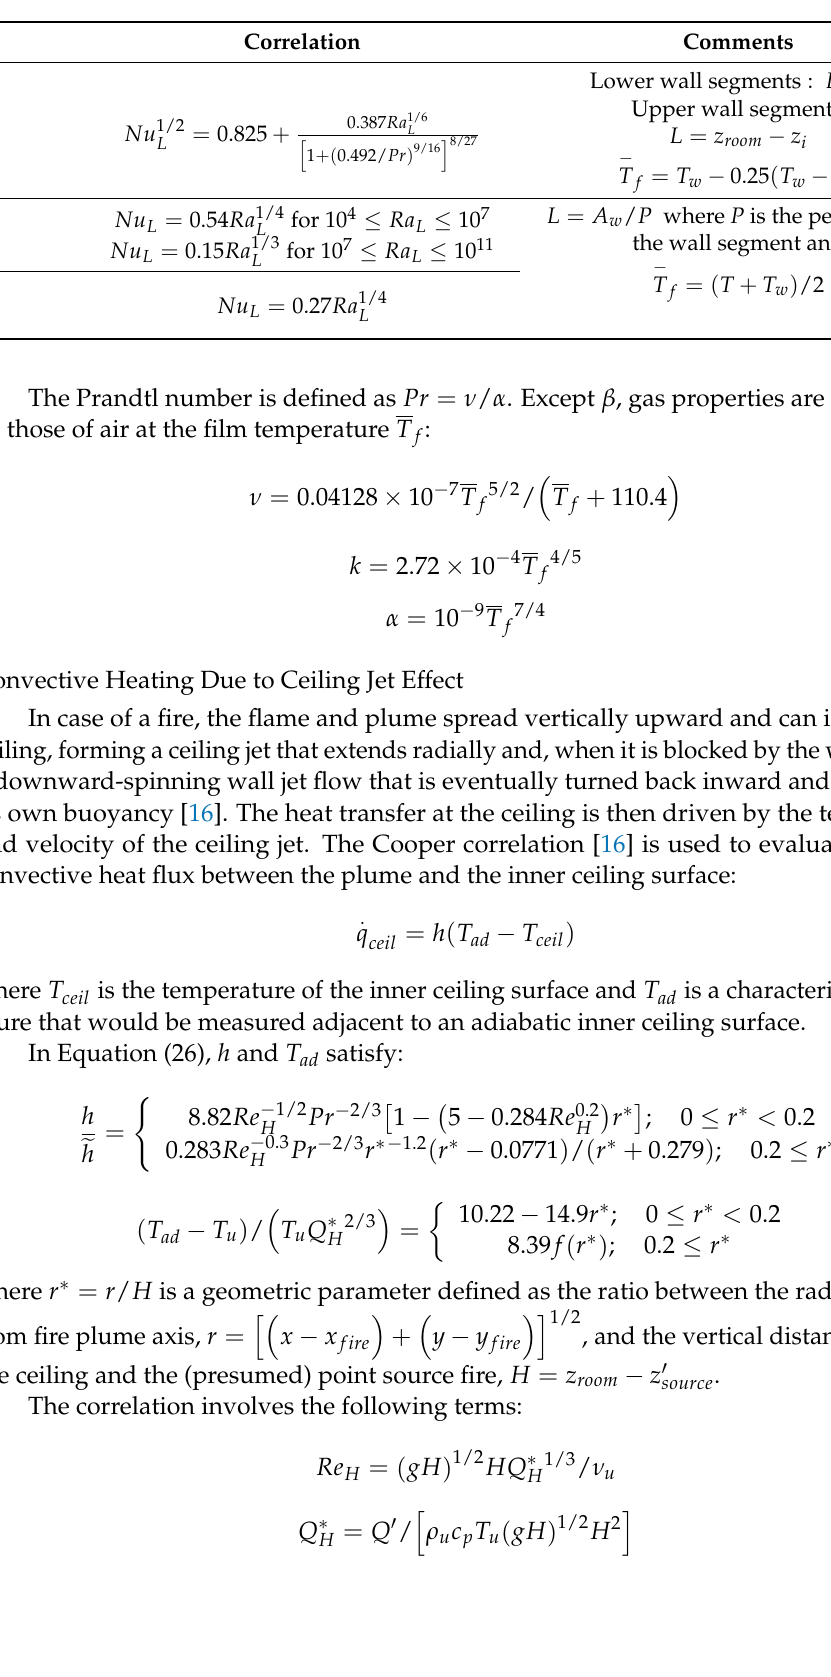
Table 1. Empirical correlations used for convection heat transfer